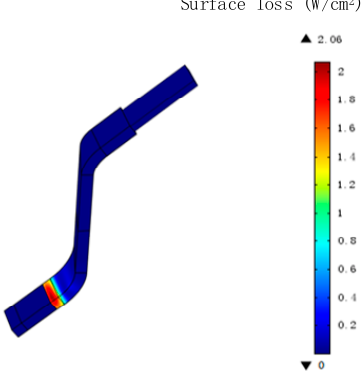
Figure 9. Surface loss distribution of the two-segment nonlinear corona protection layer.